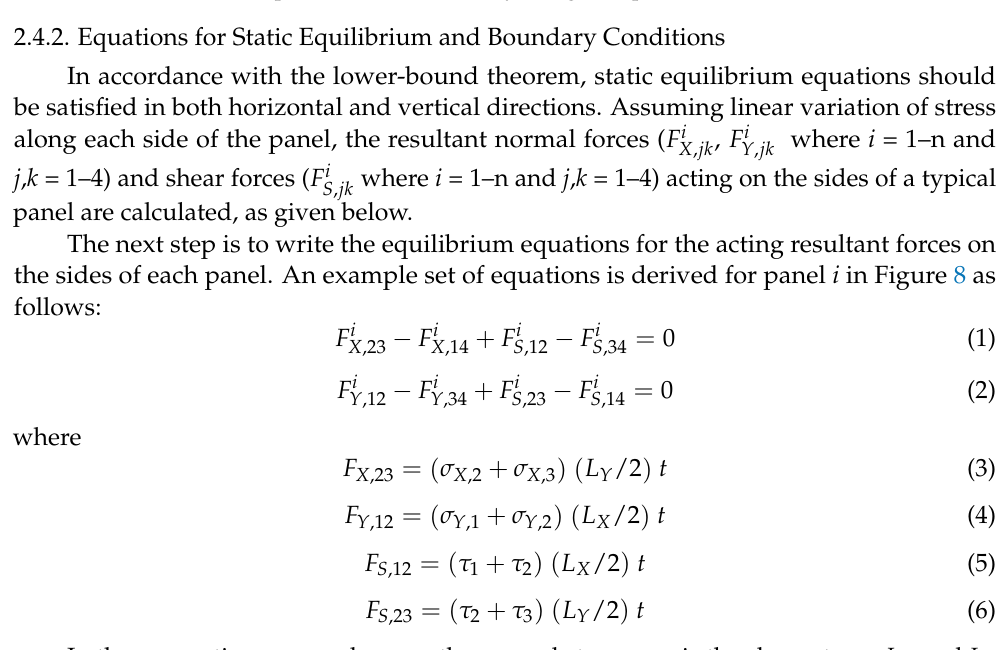
Figure 8. Idealization of a perforated URM wall by using wall panels.